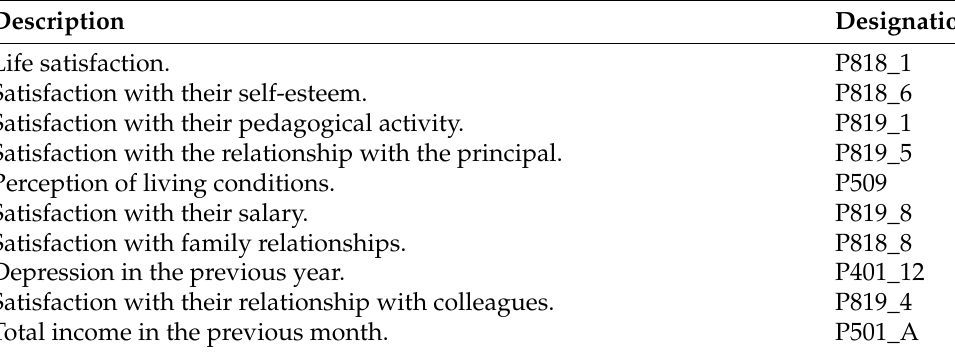
Table 2. Description of selected